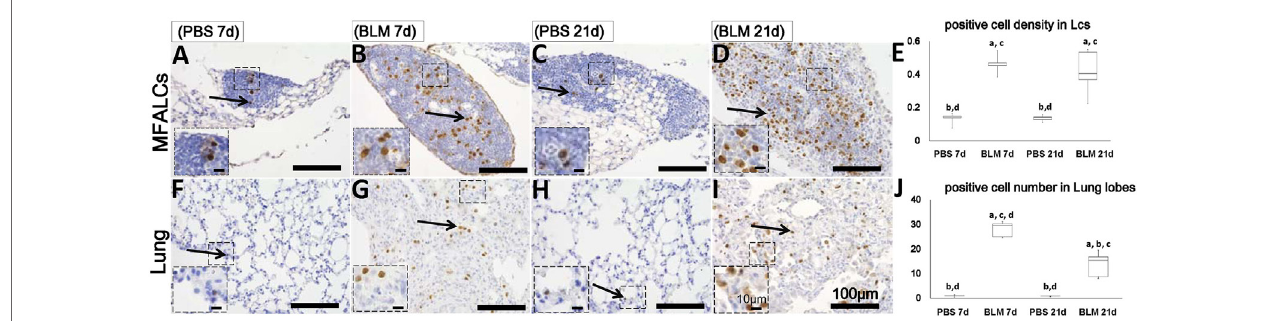
FigUre 5 | Proliferating cell populations in mediastinal fat-associated lymphoid clusters (LCs) (MFALCs) and lungs of Bleomycin (BLM)-induced pneumonitis mouse model. Immunohistochemical images show BrdU + cell in MFALCs (a–D) and lung tissues (F–i) of phosphate-buffered saline (PBS) group at 7 days, BLM group at 7 days, PBS group at 21 days, and BLM group at 21 days, respectively. (e) Density of BrdU + cells in MFALCs. (J) Average number of BrdU + cells in lung tissues of different groups. The letters a, b, c, and d: significant differences between PBS group at 7 days (a), BLM group at 7 days (b), PBS group at 21 days (c), and BLM group at 21 days (d), analyzed by the Kruskal–Wallis test, followed by the Scheffé’s method ( P < 0.05); n = 5 in each experimental group. Values = mean ± SE.